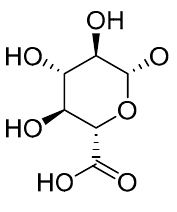
7 of 13 Figure 3. ( a ) HPLC profiles of the mixture of six model compounds (chlorogenic acid (peak 1), epigallocatechin gallate (peak 2), rutin (peak 3), quercetin (peak 4), santonin (peak 5) and alizarin (peak 6)), and the corresponding organic and aqueous phases collected at the outlets of the IPSE